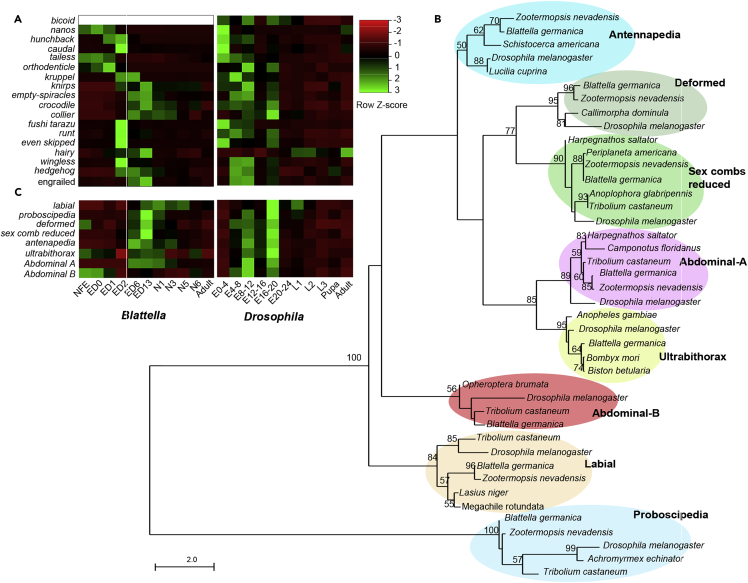
Expression of Early Patterning Genes, Hox Genes, Transcription Factors (TFs), and Genes Related to Hormonal Biosynthesis and Signaling along the Different Stage-Libraries of Blattella germanica and Drosophila melanogaster(A) Heatmap showing the expression of maternal, gap, pair-rule, and segmentation genes; bicoid has no orthologs in B. germanica.(B) Phylogenetic relationships of the Hox proteins of Blattella germanica with those of other insect species. Bootstrap values > 50 are indicated in the corresponding nodes. Scale bar indicates the number of substitutions per site.(C) Heatmap showing the expression of Hox genes. In (A) and (C), the expression is indicated in FPKM.